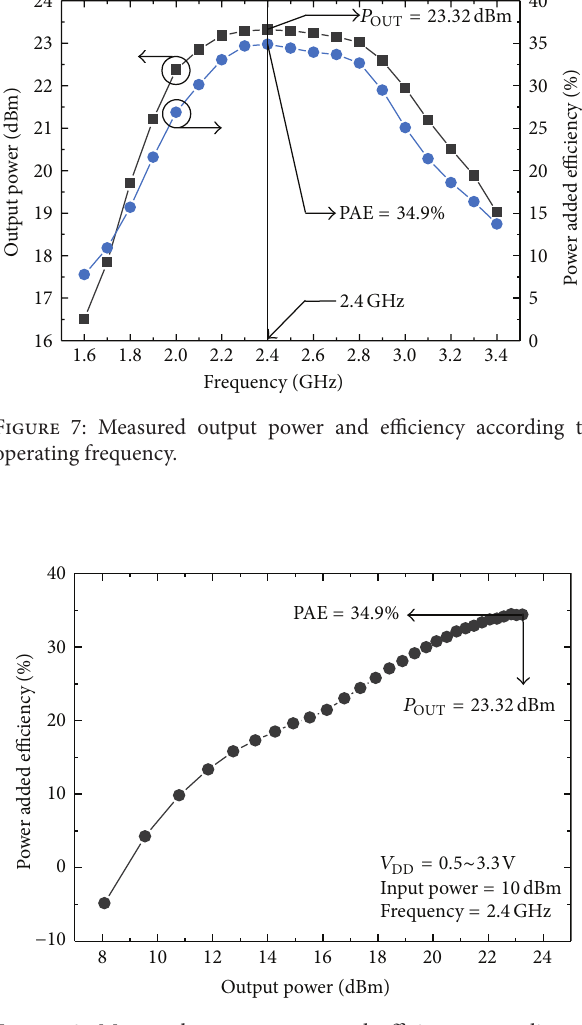
Figure 8: Measured output power and efficiency according to supply